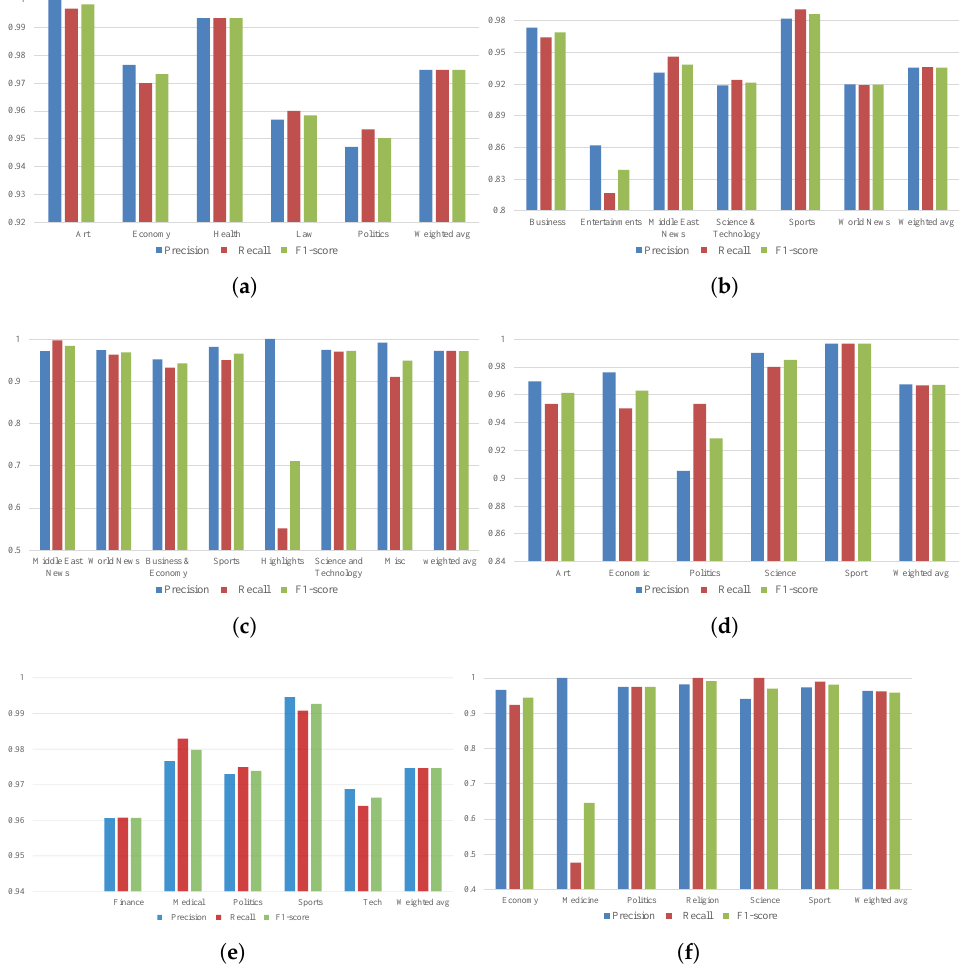
Figure 3. Precision, recall, and f1-score for: ( a ) DatasetA; ( b ) DatasetB; ( c ) DatasetC; ( d ) DatasetD; ( e ) DatasetE; and ( f )